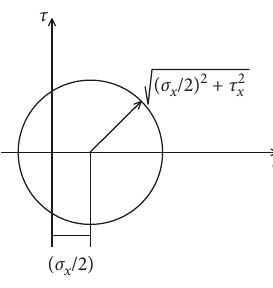
Figure 5: Stress Mohr circle.